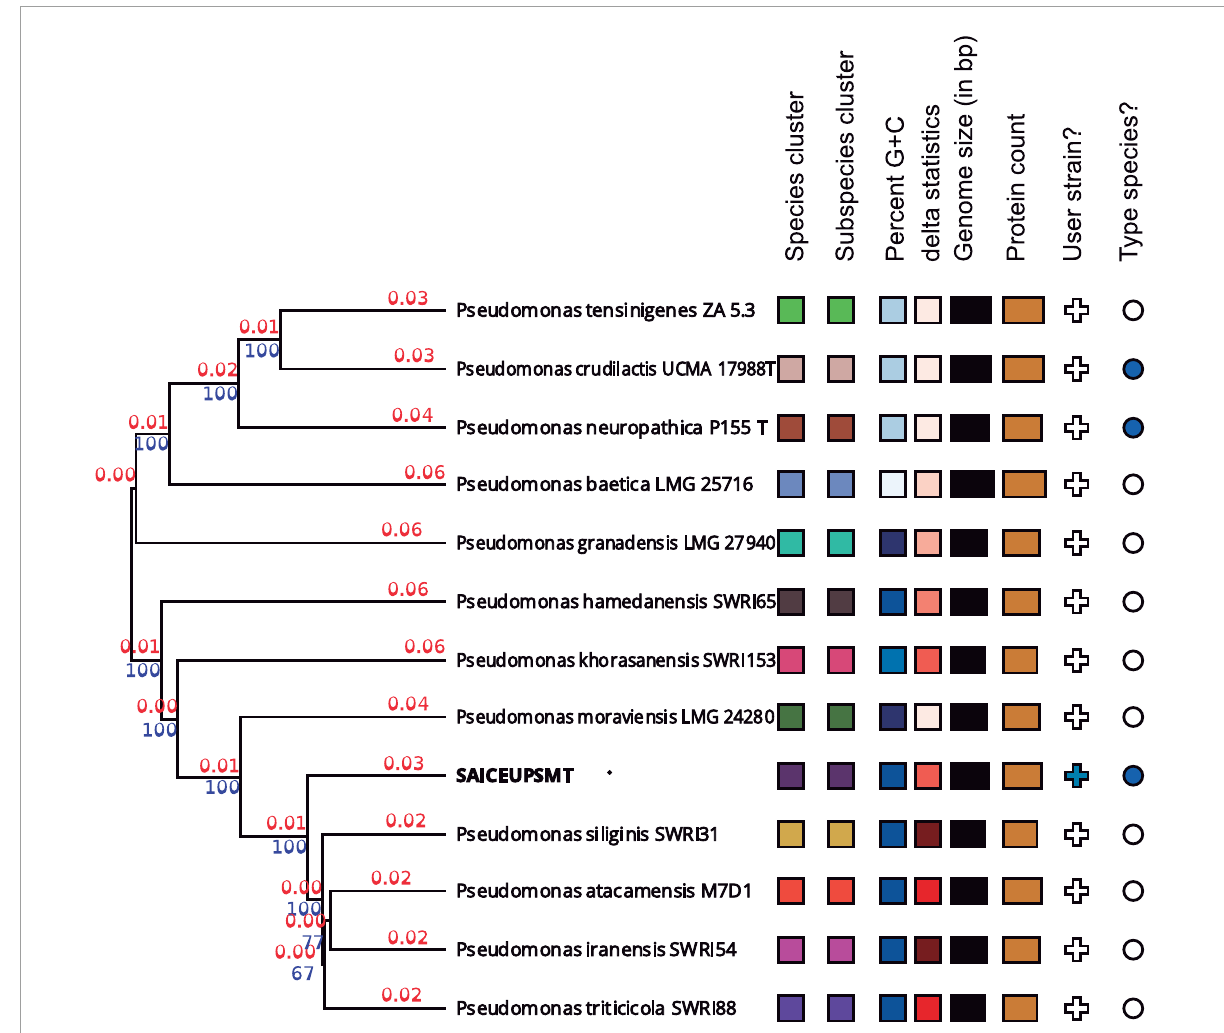
FIGURE1 Phylogenetic tree from the complete genome of the species of the genus Pseudomonas . Numerical values indicate the relative distance between the analyzed species. The branch lengths are scaled in terms of Genome Blast Distance Phylogeny (GBDP) d5. The blue numbers are GBDP pseudo-bootstrap support values > 60% from 100 replications, with an average branch support of 55.2%. The branch length values (in red) represent the evolutionary time between two nodes. Unit: substitutions per sequence site. The tree was rooted at the midpoint.